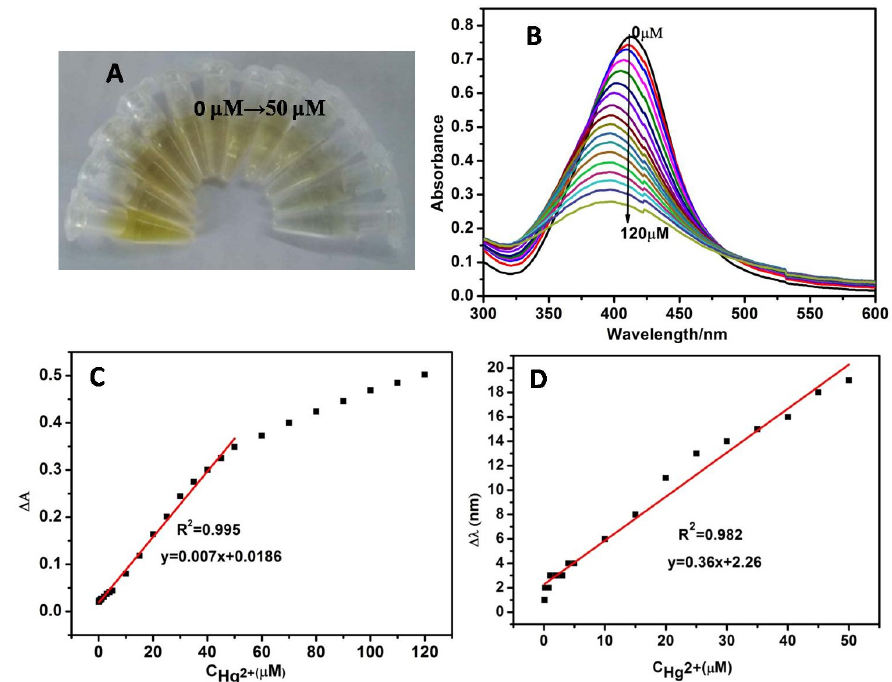
Figure 6. ( A ) The picture of color change and ( B ) UV–VIS spectroscopy of CMS/AgNPs colloidal solution with different concentration of Hg 2+ , ( C ) the liner relative absorption intensity Δ A, and ( D ) the SPR band shift Δ l over the concentration of Hg 2+ is within the range of 0–50 μ M. Polymers 2019 , 11 , x FOR PEER REVIEW